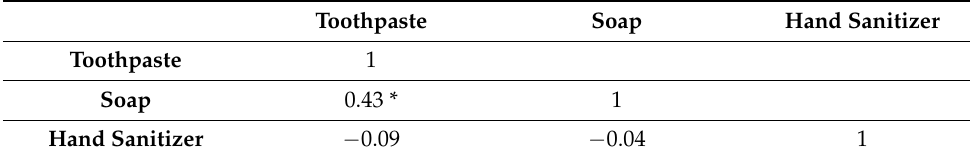
Table 9. Pairwise correlation matrix for the total number of coupons. Soap is Method body wash. * p < 0.01.